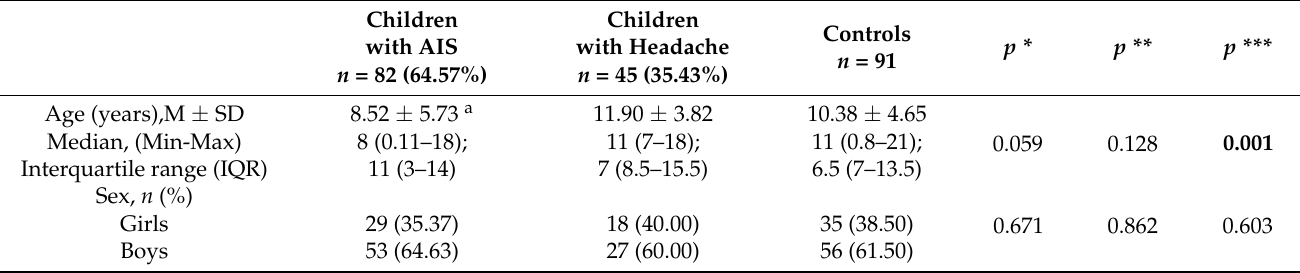
Table 1. Characteristics of age and sex in subgroups of patients with AIS and headache as well as in